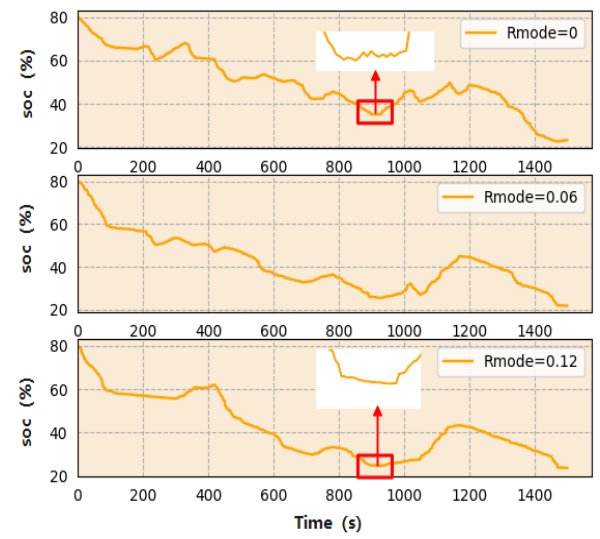
Figure 18. Battery power curve.